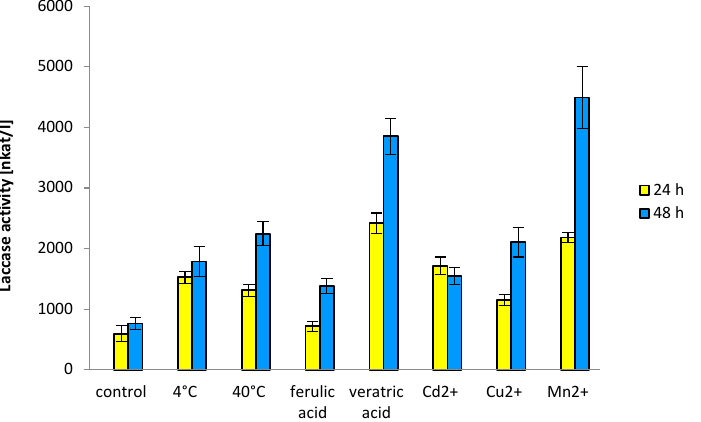
Figure 2. Effect of temperature, ferulic and veratric acids, Cu, Mn, and Cd ions on enzymatic activities of laccase after 24 and 48 h after induction of C. unicolor . Error bars represent the standard deviation of the mean ± SD for three independent measurements (n = 3).